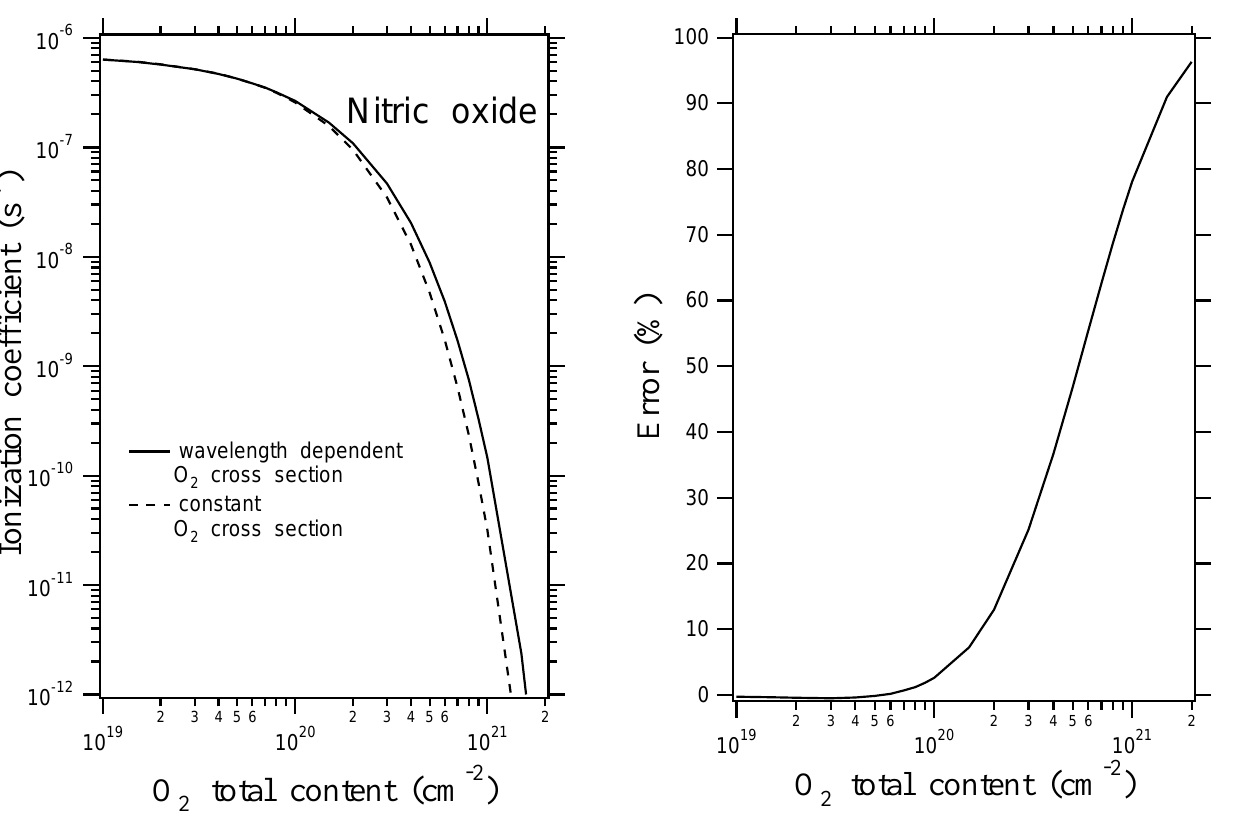
Fig. 11. Error introduced by the use of a constant O 2 absorption cross section. Table 2. Parameters for the reduction factor R M